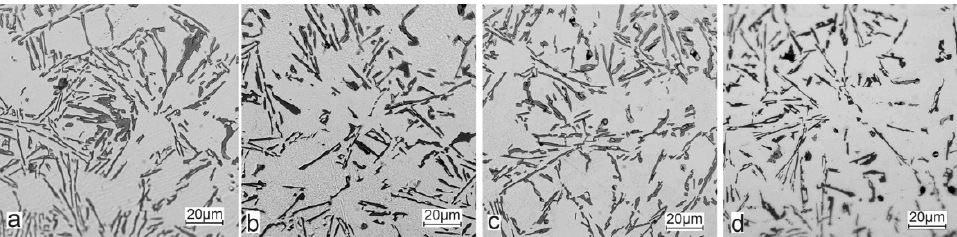
Figure 7. Microstructure of AlSi10 alloy with Sn addition—mag. 500×: ( a ) AlSi10; ( b ) AlSi10Sn0.2; ( c ) AlSi10Sn0.7; ( d ) AlSi10Sn1.7.